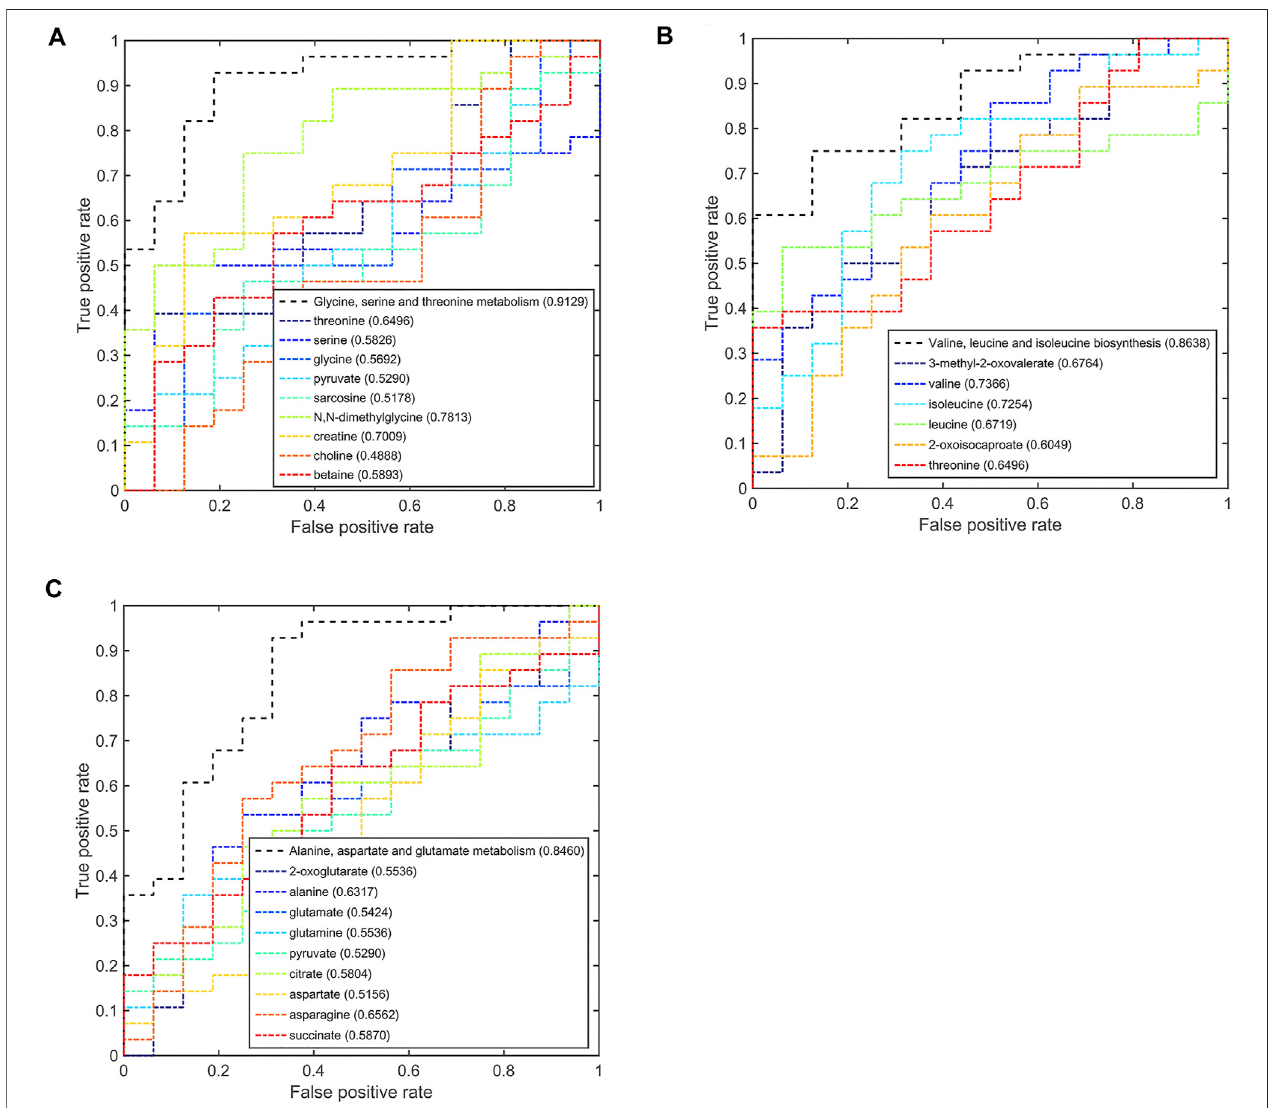
FIGURE 6 | Multi-ROC curves assessing discriminant capabilities of the signi fi cantly disturbed metabolic pathways in the pPR patients compared with the pSD patients. The AUC values shown in brackets are used to evaluate the performances of various biomarker models: (A) glycine, serine, and threonine metabolism; (B) valine, leucine, and isoleucine biosynthesis; (C) alanine, aspartate, and glutamate metabolism.